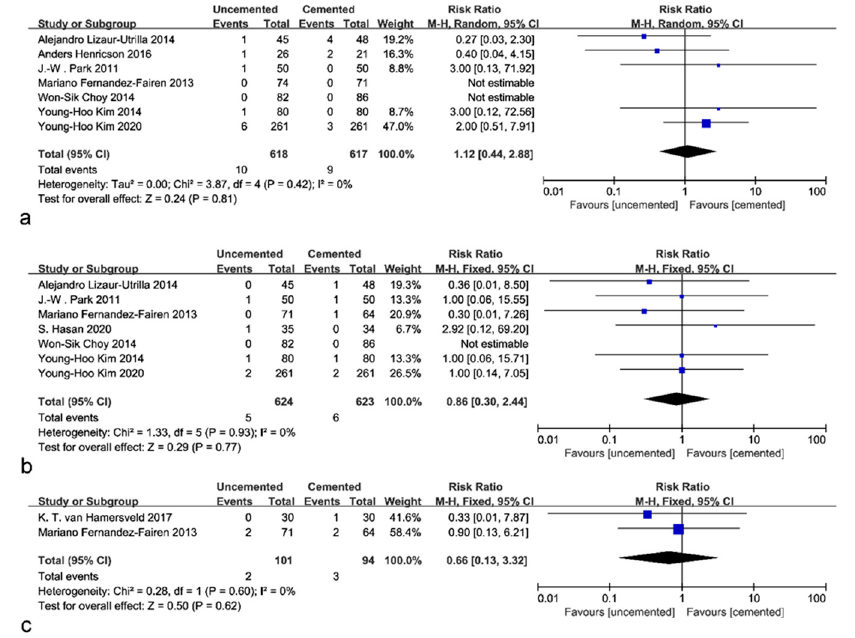
Figure 5. Forest plot of complications. ( a ) Forest plot of aseptic loosening [23,24,26–29,31]. ( b ) Forest plot of infections [23–25,27–29,31]. ( c ) Forest plot of thrombosis [24,30].